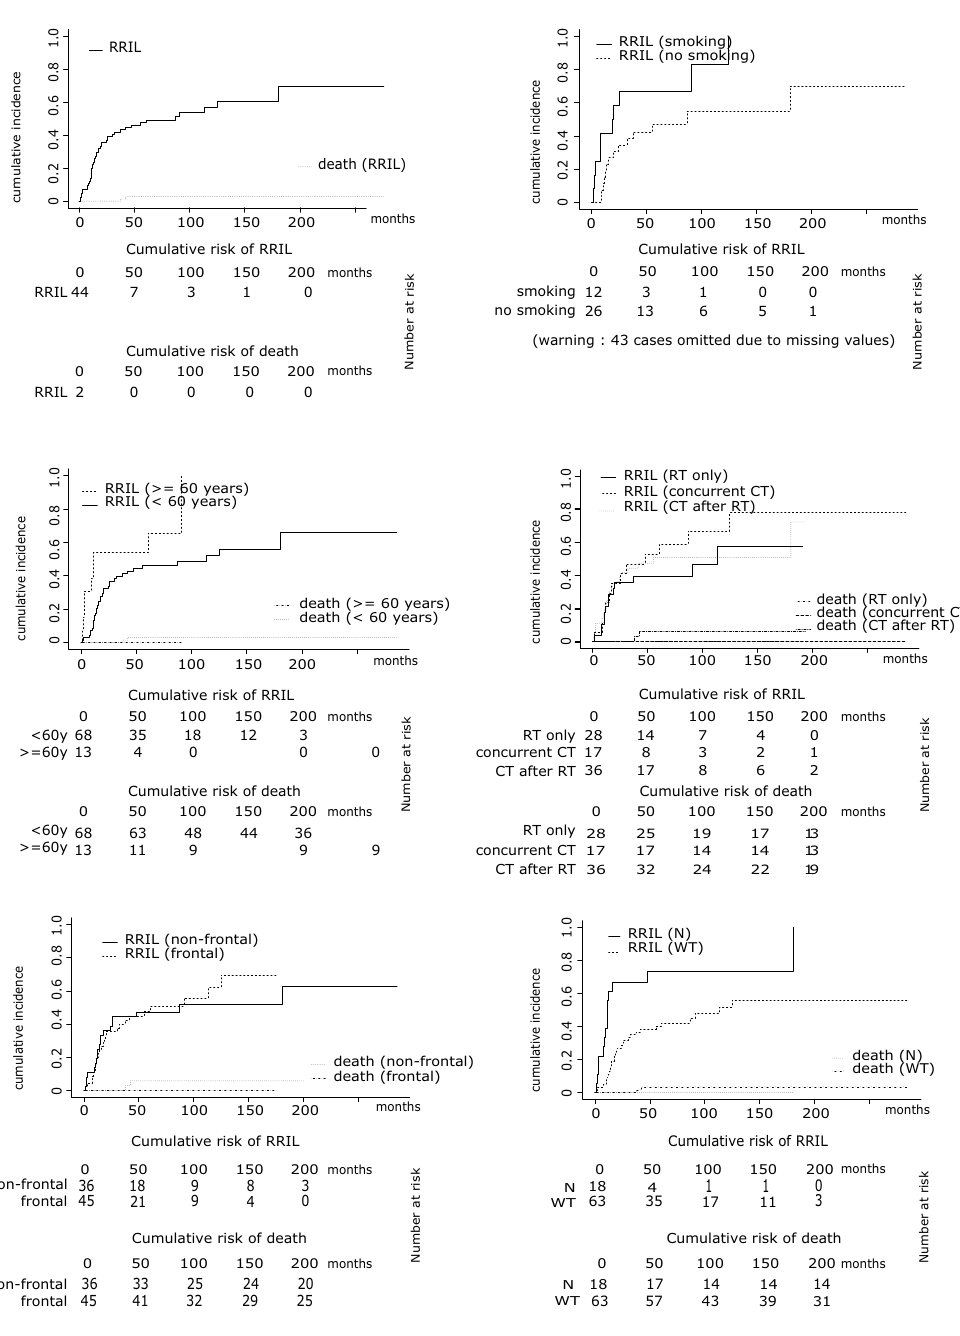
Figure 2. ( a) Cumulative incidence of radiographical radiation-induced leukoencephalopathy (RRIL); FLAIR-hypersignal, enlargement of lateral ventricles or cortical atrophy corresponding to a modified Scheltens- score over 10; ( b) cumulative incidence of RRIL in patients with a history of smoking and in non-smoking patients, n = 38; ( c ) cumulative incidence of RRIL in patients over age 60 (≥ 60 years) and patients under age 60 (< 60 years) at RT time; ( d ) cumulative incidence of RRIL in patients who received different treatments: RT only, RT with concomitant chemotherapy (NU or TMZ), or RT with chemotherapy following RT (NU or TMZ); ( e ) cumulative incidence of RRIL for frontal tumors and non-frontal tumors; ( f ) cumulative incidence of RRIL for PPARg variants (rs2120825): N non-wild-type (GG, TG), WT wild-type